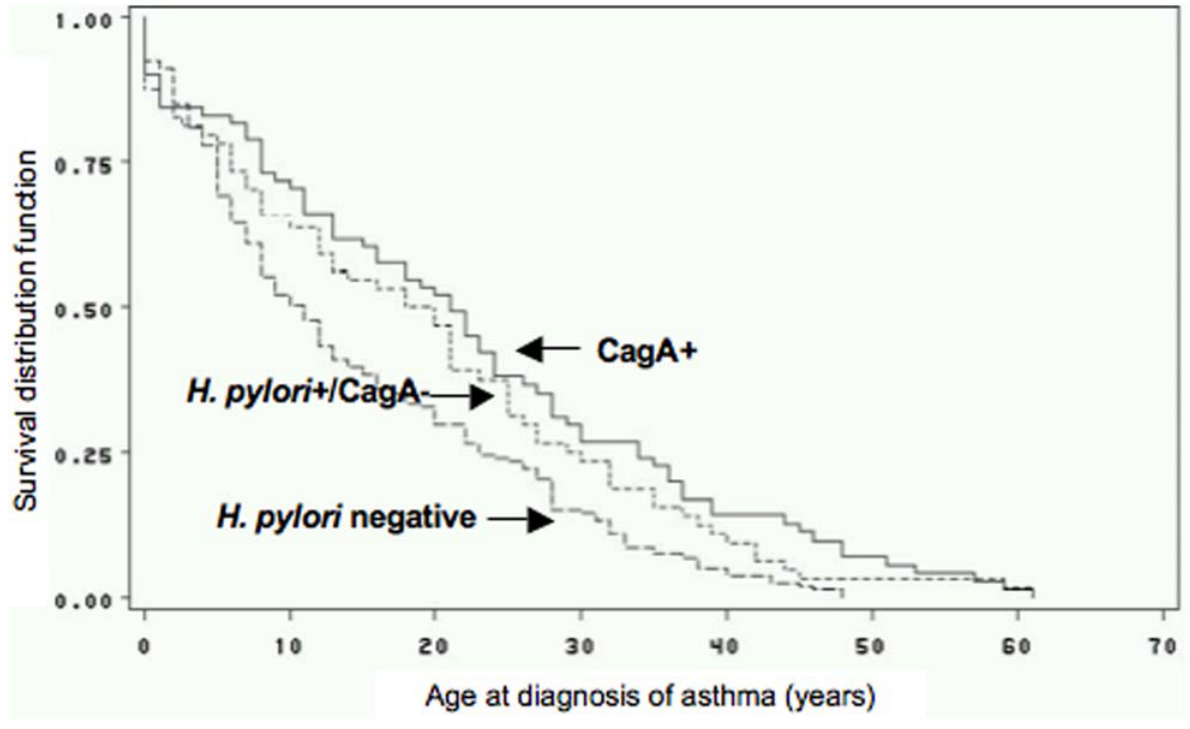
Figure 1. Kaplan-Meier estimation of asthma-free survival among 294 adults with asthma according to H.pylori status (– – – H.pylori negative (n=159); ---- H.pylori + /CagA 2 (n=64); CagA + (n=71). a a (Data for age of asthma onset are not available for 24 of the 318